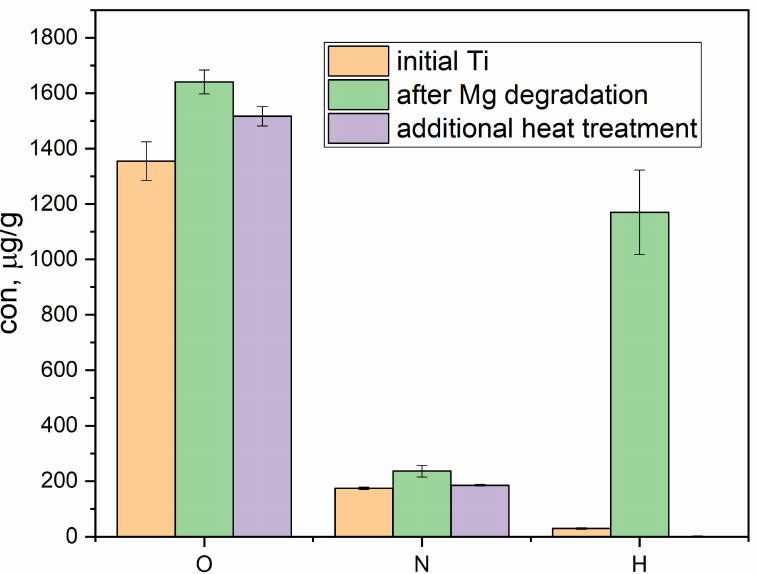
Figure 5. Content of H, N and O in titanium part: initial Ti, after degradation of Mg alloy sintered with Ti and after additional heat treatment at 1100 ◦ C in a